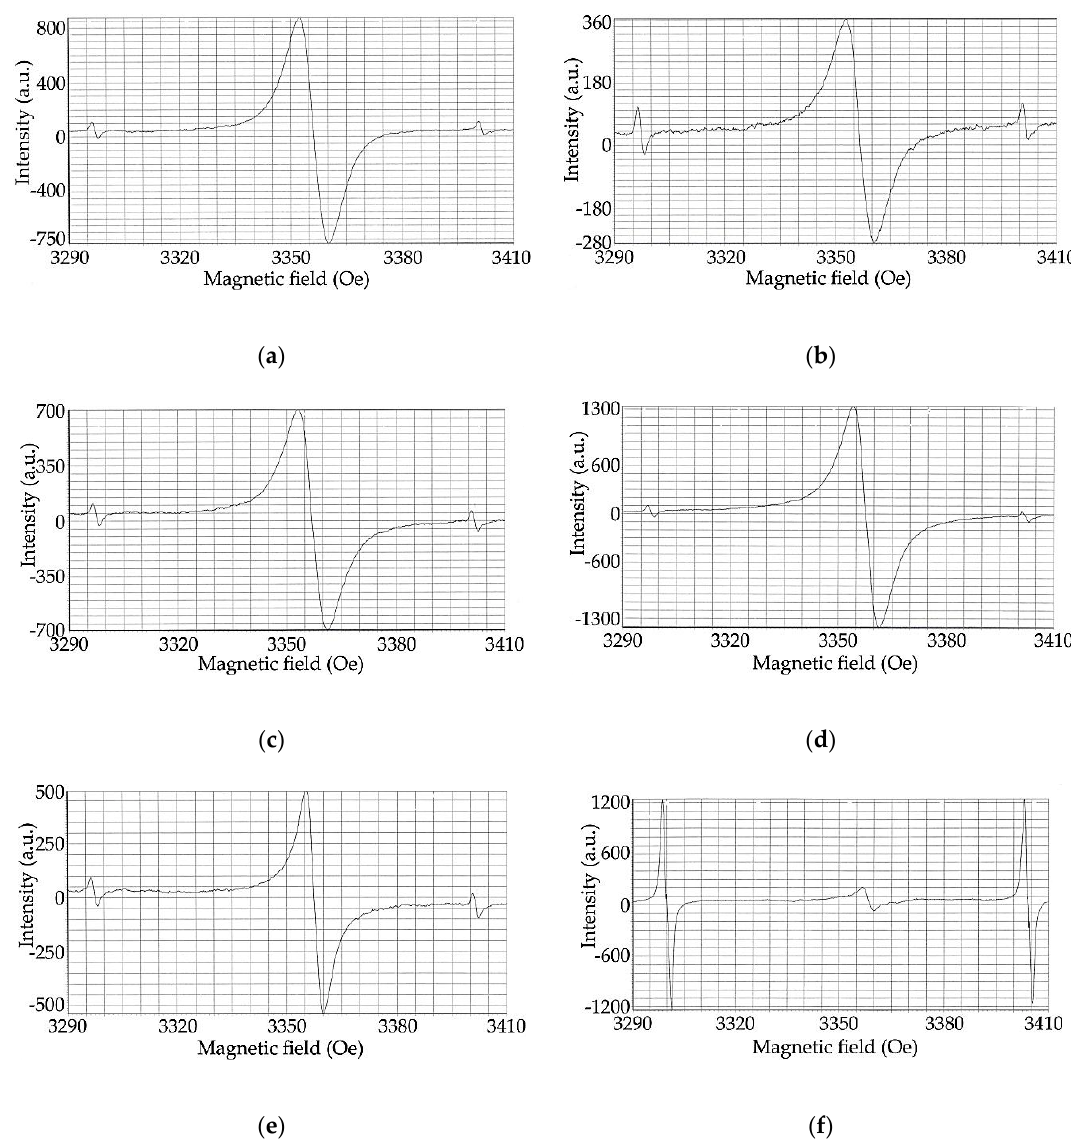
Figure 8. EPR spectra of rice husk hydrolytic lignin and its carbonization products: ( a ) L; ( b ) L-300; ( c ) L-450; ( d ) L-550; ( e ) L-650; ( f ) ions Mn 2+ in MgO as reference sample. Table 4. Parameters of EPR spectra of rice husk hydrolytic lignin and its carbonization products